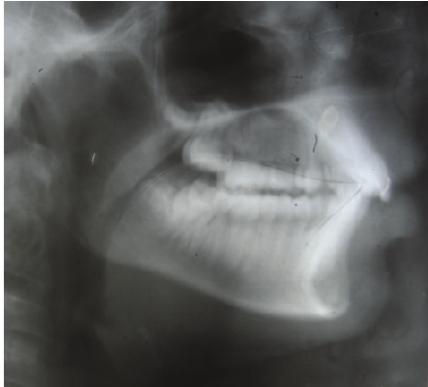
Figure 4: pre-treatment cephalogram showing low positioning of tongue at rest